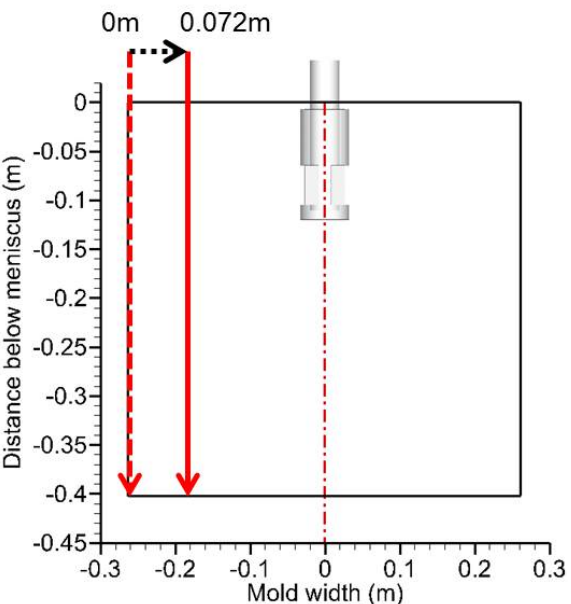
narrow side is the lowest and increases as the distance from the narrow side increases.